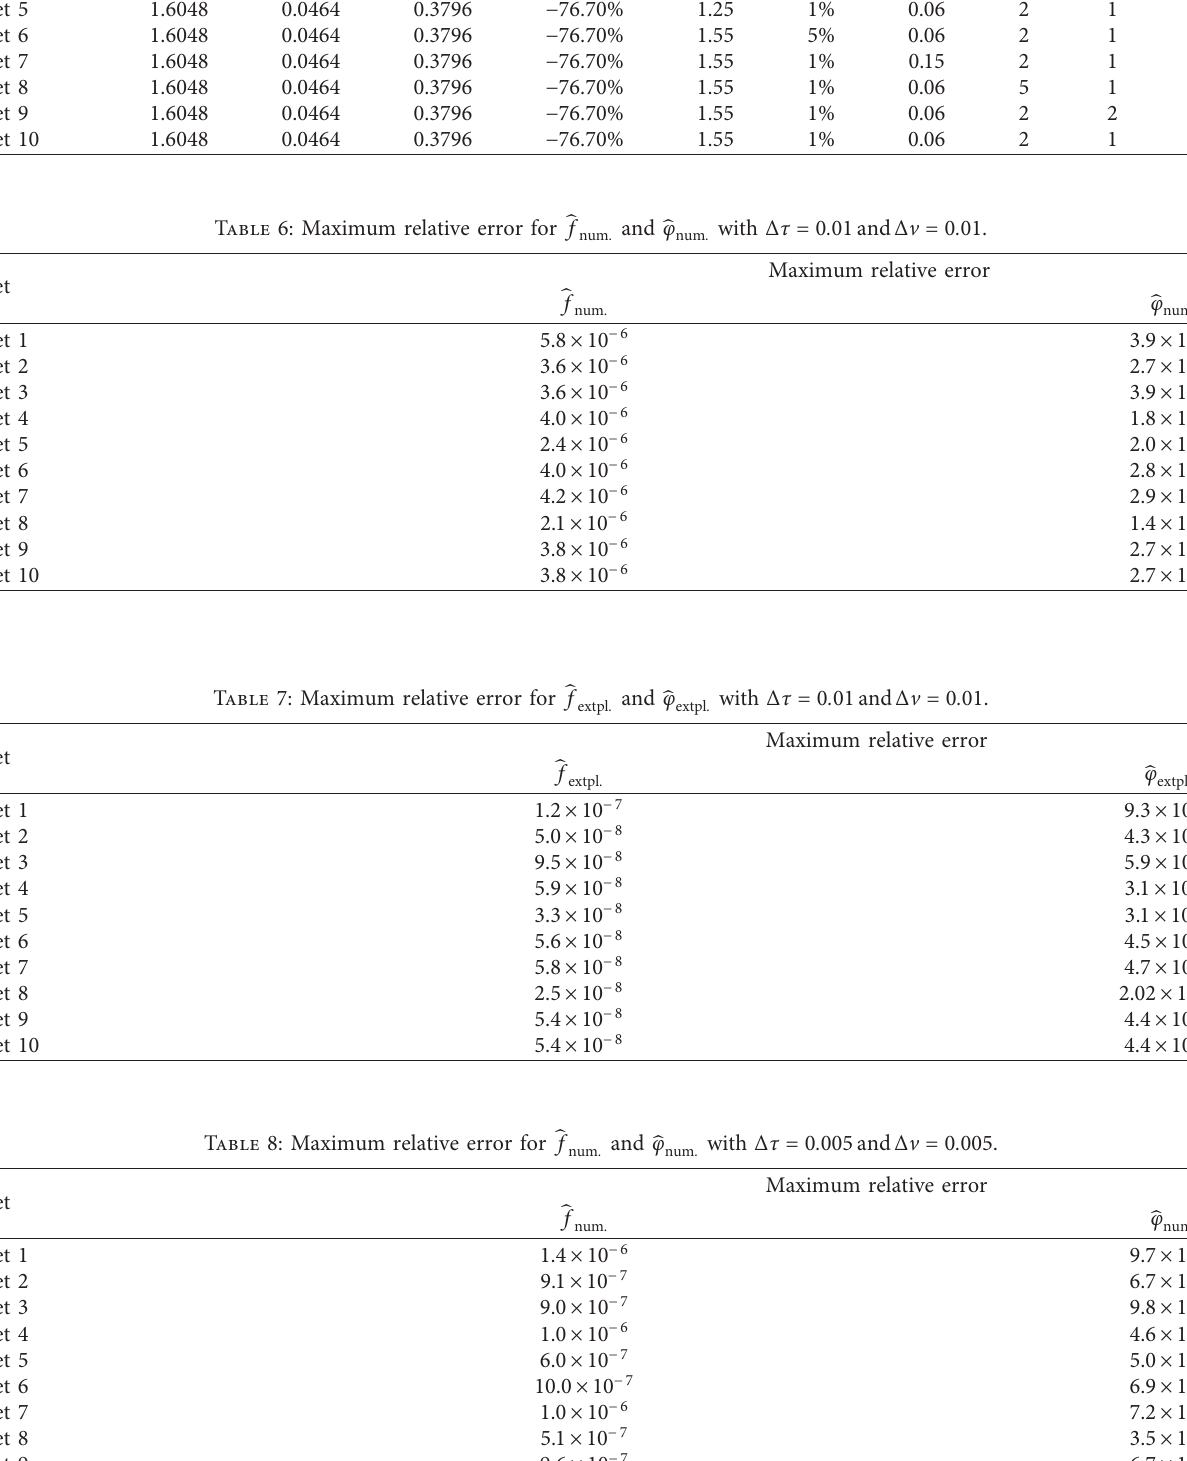
Table 5: Values for the parameters κ , θ , ξ , ρ ,A, r, β , c ,a